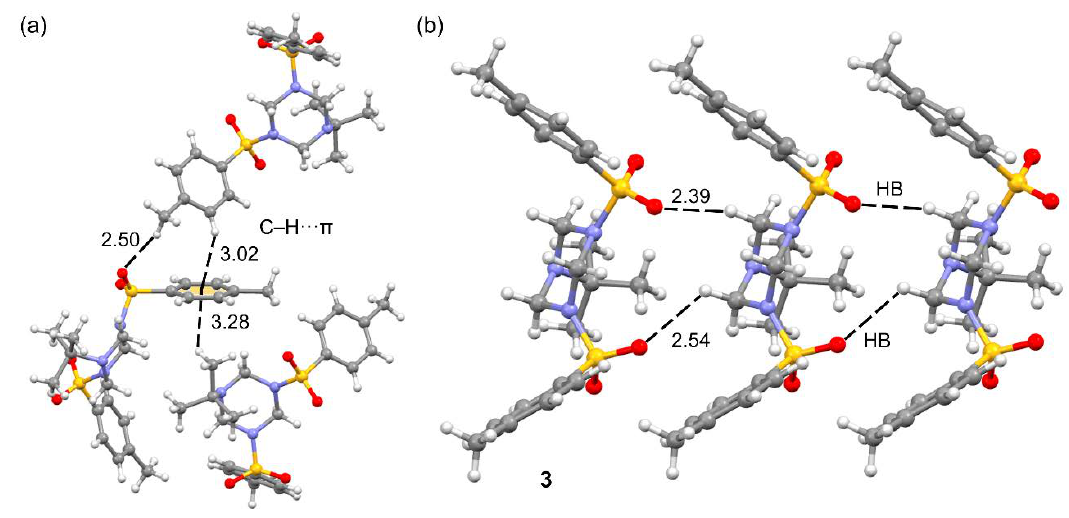
Figure 4. ( a ) C– H···π···H –C assembly in the solid state of structure 3 . Distances in Å. ( b ) 1D Figure 4. ( a ) C–H ··· π ··· H–C assembly in the solid state of structure 3 . Distances in Å. ( b ) 1D